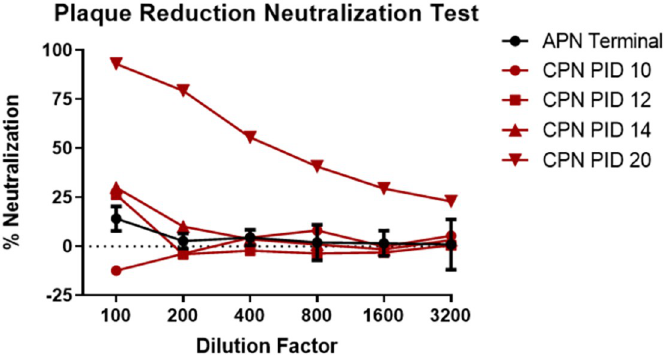
Fig 9. Neutralizing antibody responses as measured using a pseudovirion plaque reduction neutralization test. Shown in this figure is the percent of neutralization at various serum dilutions. Average terminal data for APN are show in black, with data for various PIDs shown in red for the